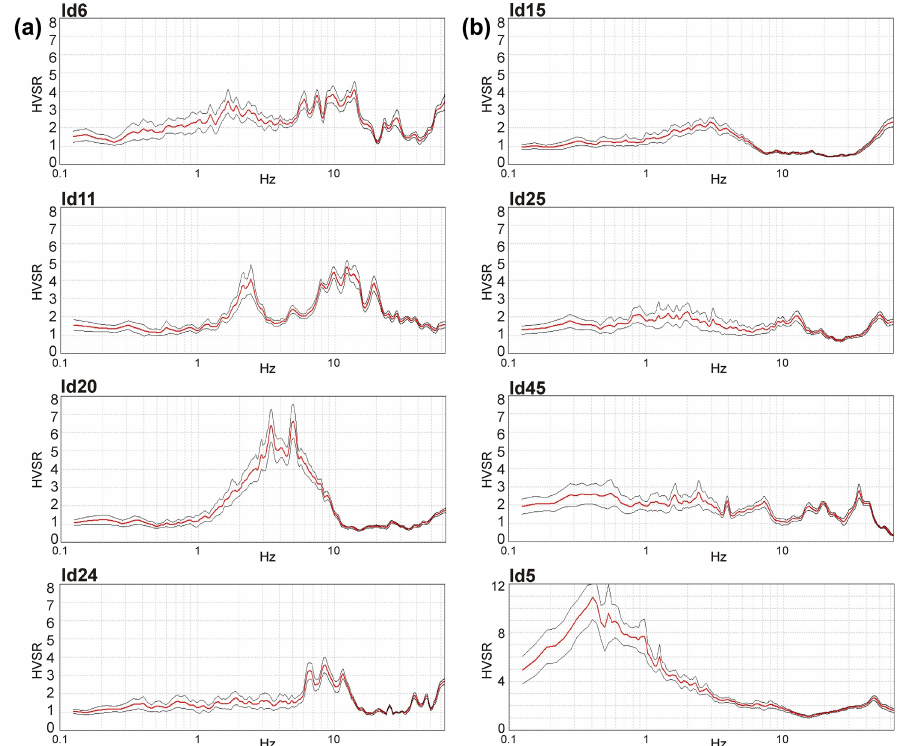
Figure 6. (a) Examples of microtremor measurements with several peaks in HVSR curve. (b) Examples of microtremor measurements with no HVSR response or pronounced low-frequency noise (Id5). Locations of measurements are shown in Fig. 2. Thin lines represent the 95% confidence interval.